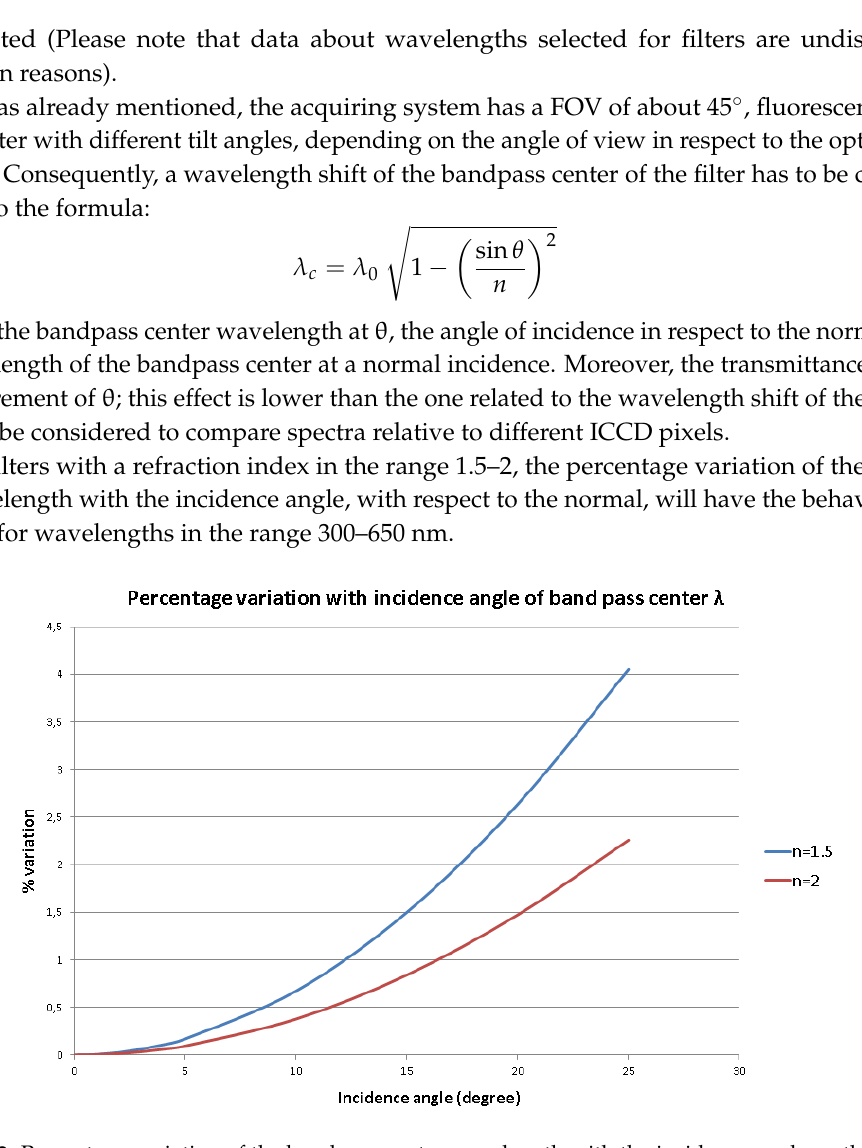
Figure 2. Percentage variation of the bandpass center wavelength with the incidence angle on the filter surface in the range 300–650 nm.